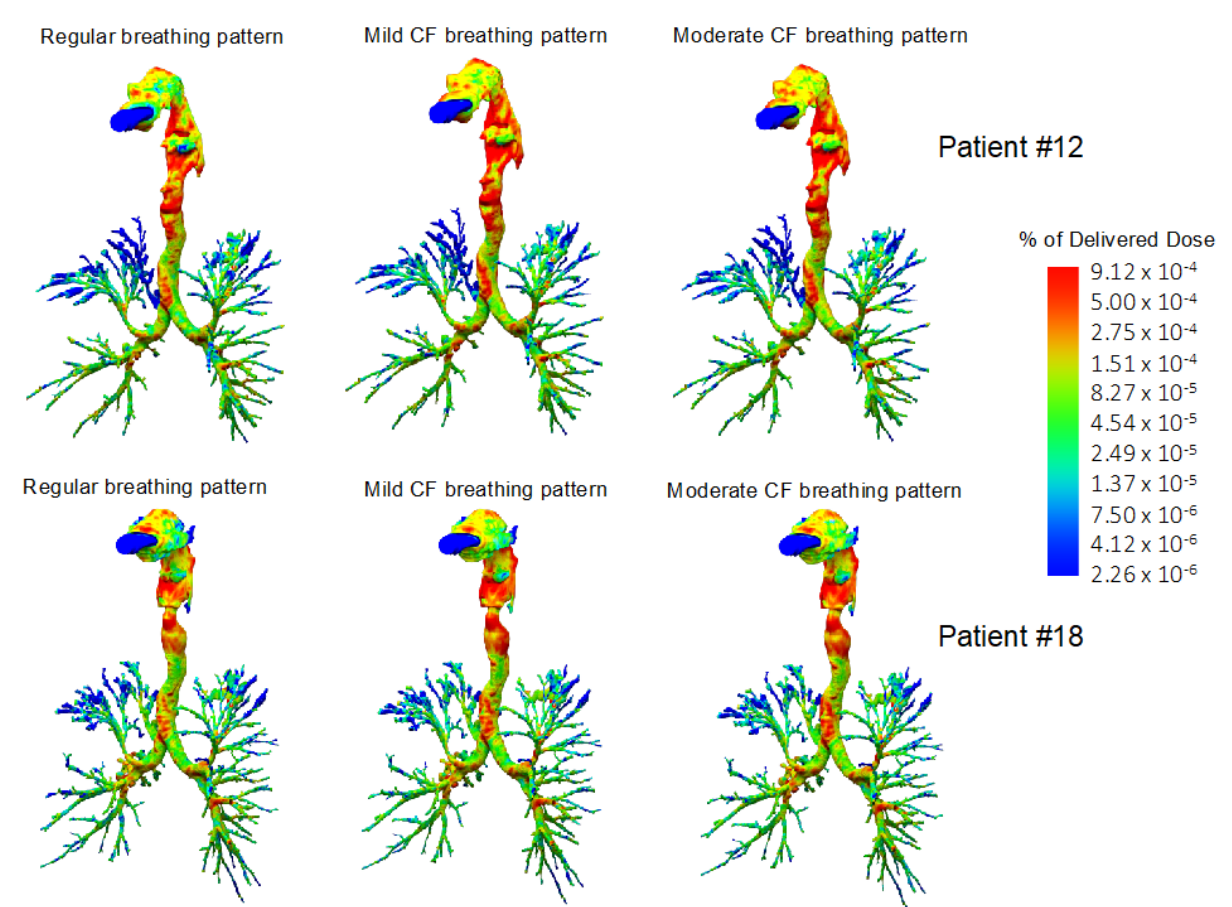
Figure 4. Three-dimensional reconstruction of the airways and levofloxacin aerosol deposition in two representative cystic fibrosis (CF) patients (Patient #12, moderate CF, top row; Patient #18, mild CF, bottom row). Computational fluid dynamics simulations showed a higher extrathoracic levofloxacin deposition with mild and moderate CF breathing patterns compared with the “regular breathing” pattern. Levofloxacin aerosols distributed preferentially to the lower lung lobes, irrespective of the breathing